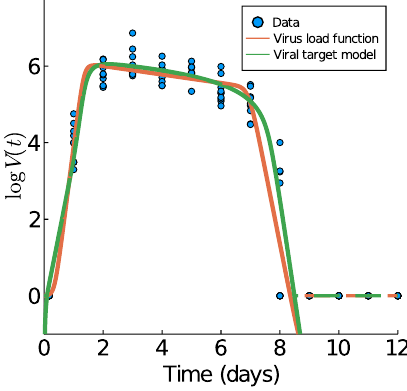
Figure 4. Fitting results of the virus load function (1) in orange and the virus-target model (9) in green to influenza A data of mice [10]. The effective virus load curve (5) for both models are indicated with dashed